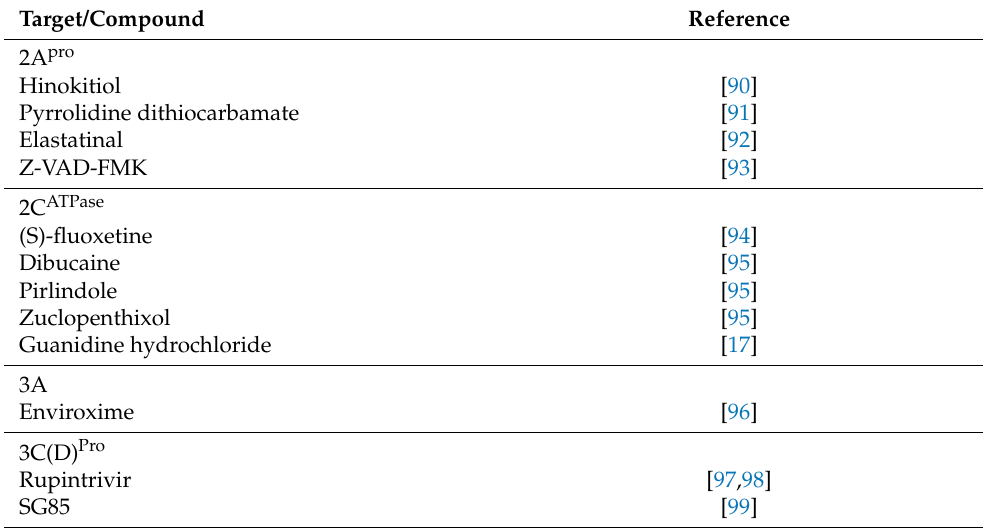
Table 2. List of compounds targeting viral non-structural